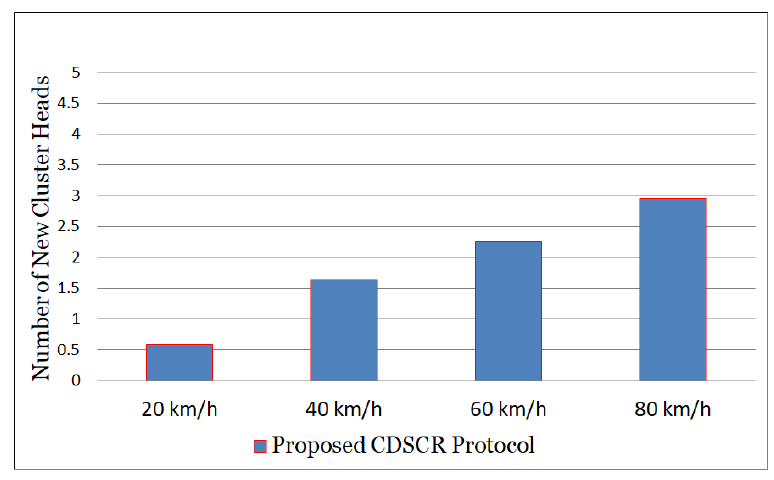
Figure 9. Number of new cluster heads versus node mobility.